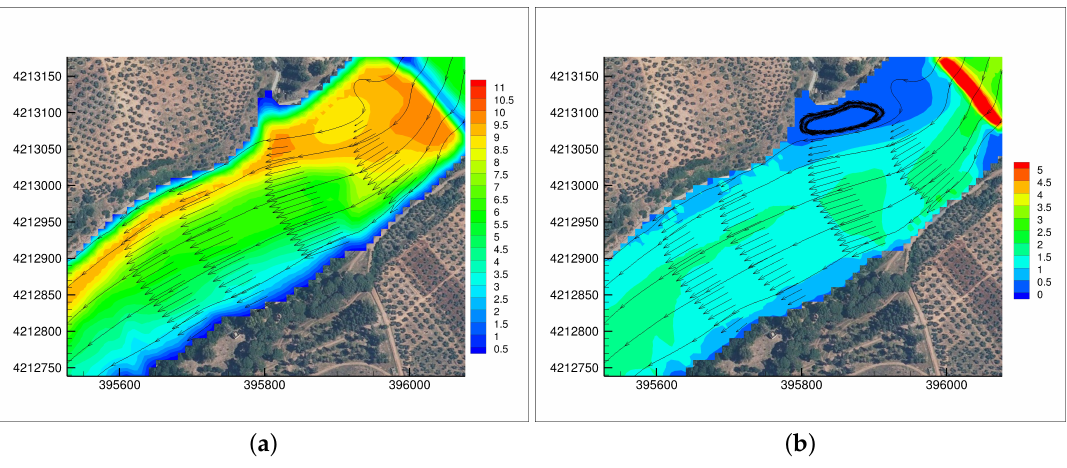
Figure 8. Details of the simulated ( a ) flow depth; and ( b ) velocity magnitude from the dam to the Spa ( x ≤ 775 m) with Q = 1400 m 3 · s − 1 . Representative streamlines and velocity vectors are also